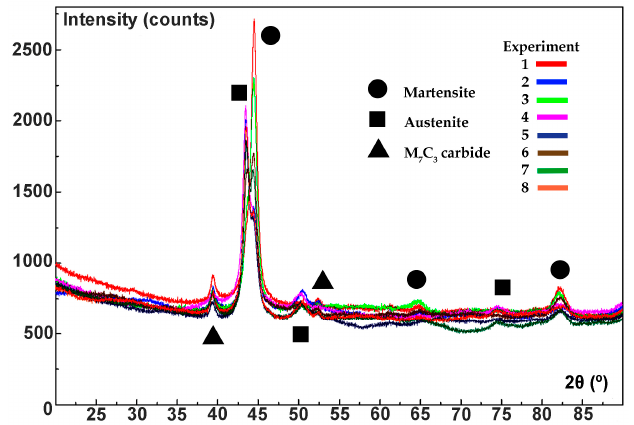
( b ) Figure 1. As-cast Microstructure: ( a ) ×500 magnification; ( b ) ×1000 magnification. Figure 2 shows the diffractograms obtained in the 8 experiments. The analysis was carried out after having performed all the heat treatments indicated in Table 3 (array of experiments). The Bragg peaks corresponding to martensite were indexed to their reflections with Miller indices (110), (200) and (211). The Bragg peaks corresponding to austenite were indexed to their reflections with Miller